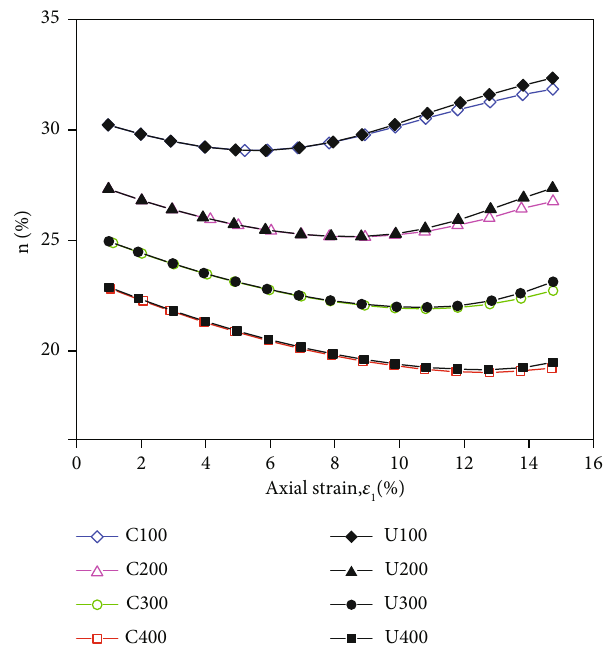
Figure 7: Porosity evolution curve of samples under di ff erent con fi ning pressures.